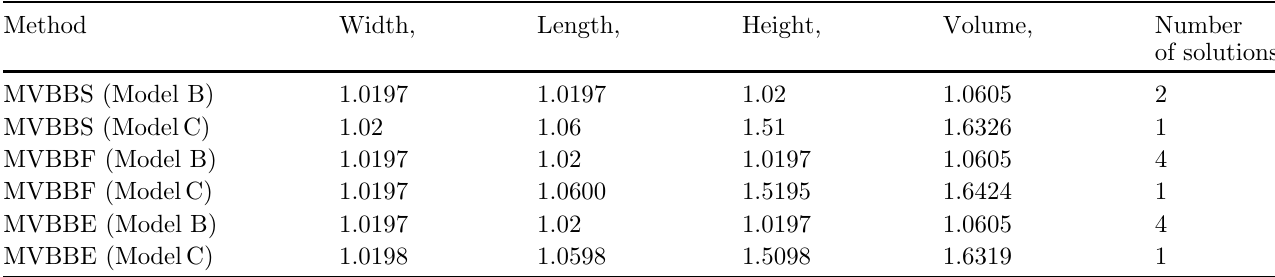
Table 4. The computation results of the developed methods for Model B and Model C (in normalized